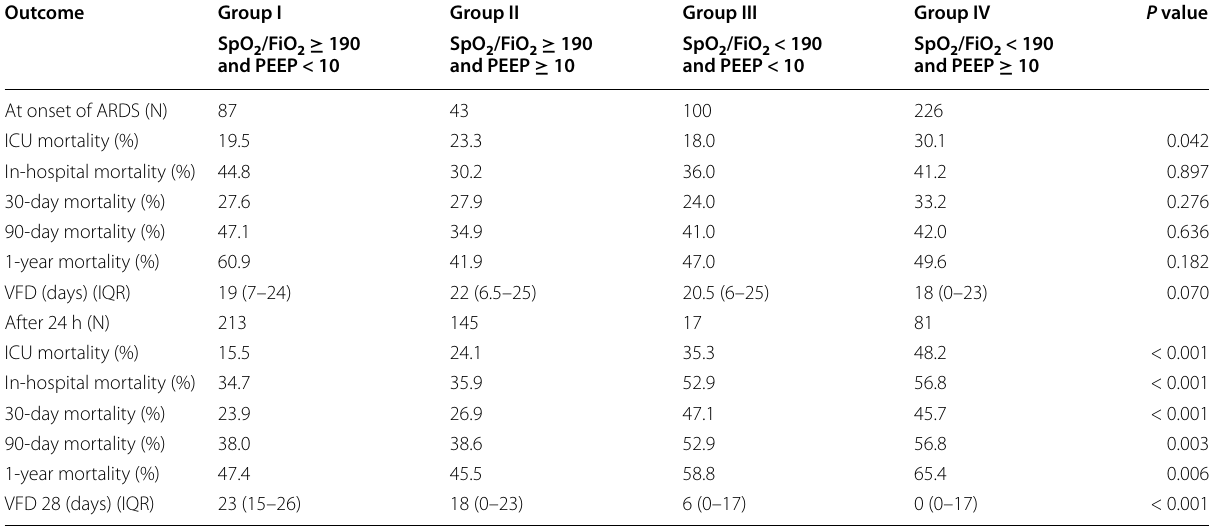
VFD-28 ventilator-free days and alive at day 28, IQR interquartile range, CI confidence